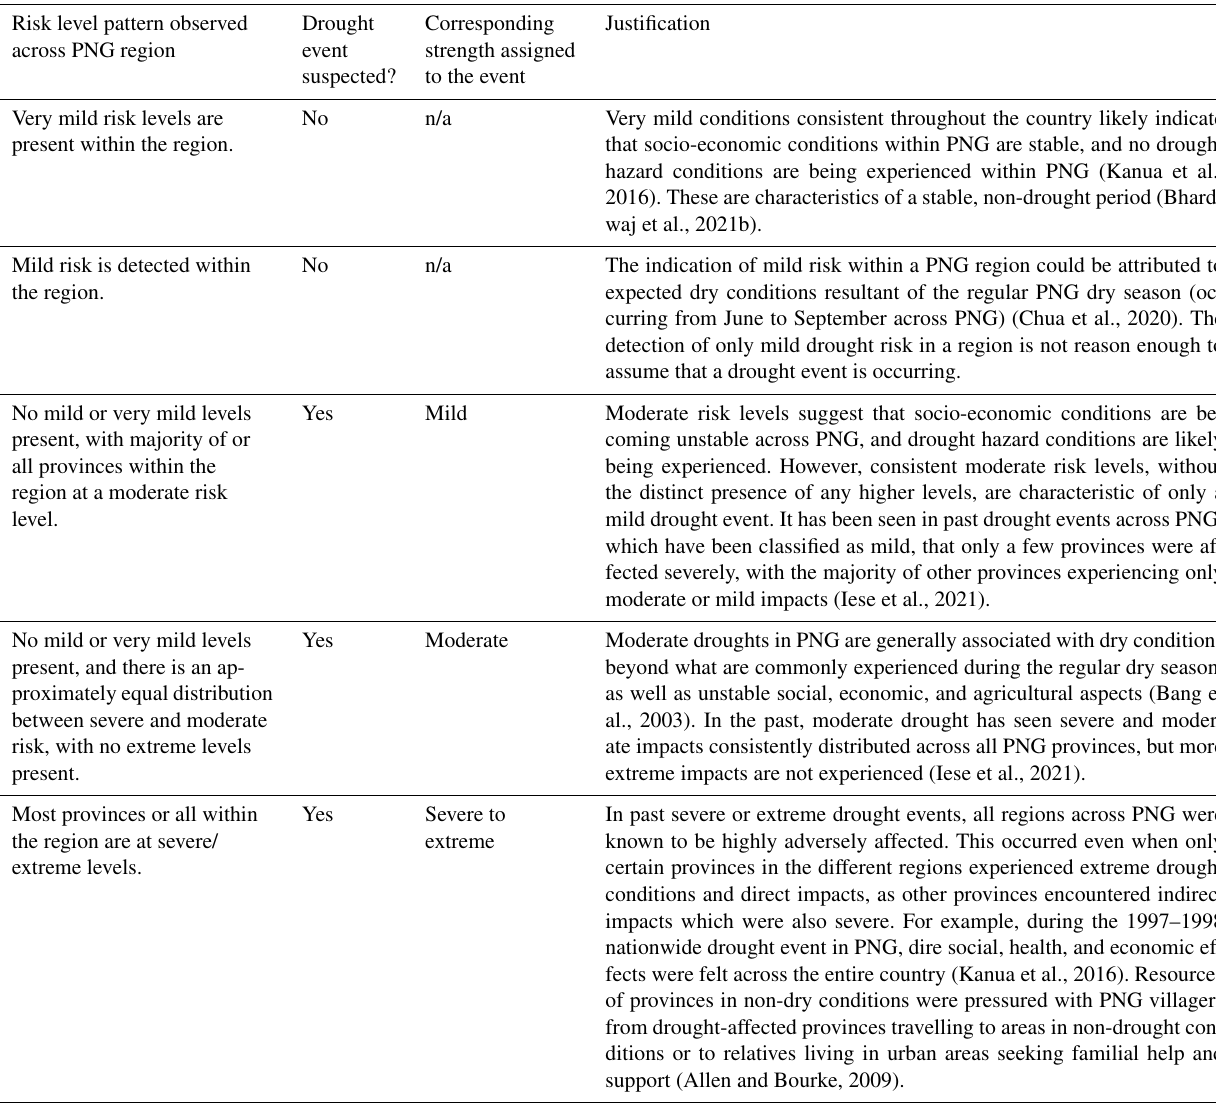
Table 4. Risk level pattern observed to determine whether a drought event was suspected as occurring throughout each PNG region. n/a – not